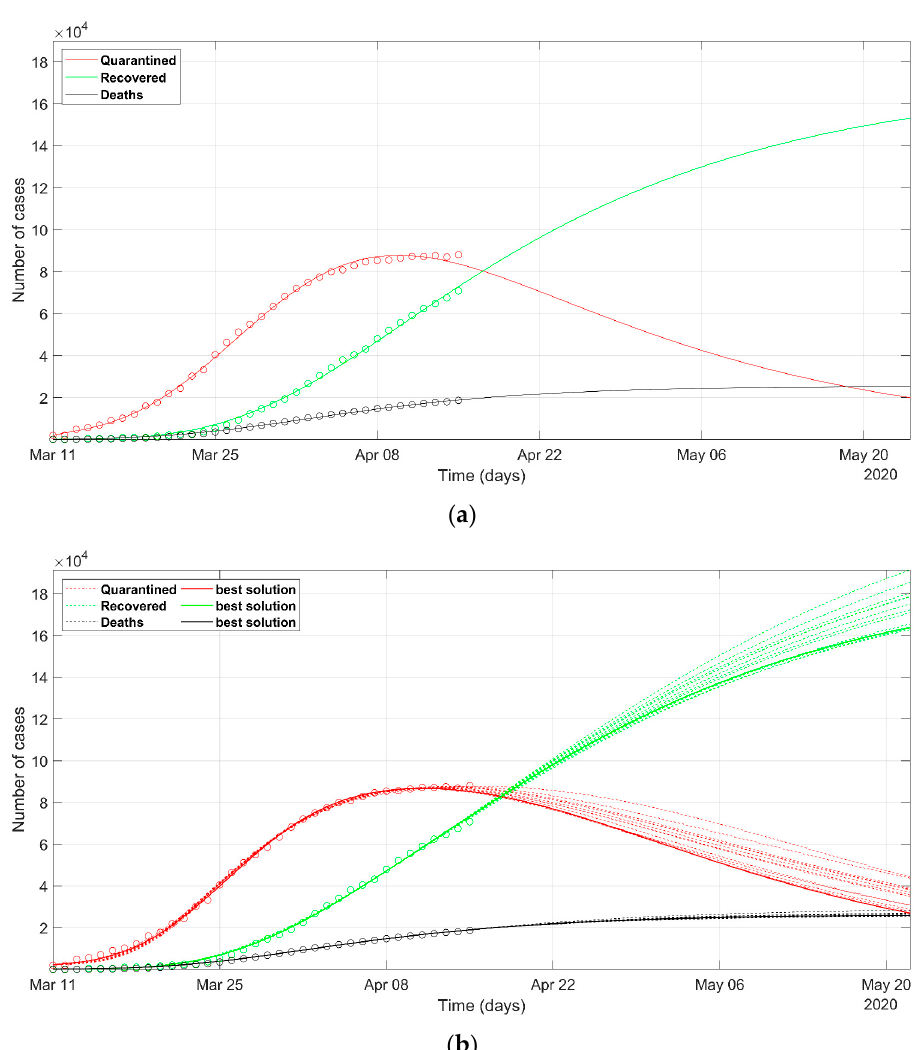
Figure 7. Observed data (circles) of quarantined (red), recovered (green), and deaths (black) for Spain, updated on 15th April 2020. The continuous lines refer to the predicted evolution in 30 days according to the SEIR model solved with ( a ) deterministic approach, ( b ) stochastic approach. In ( b ) the solid line refers to the best PSO solution, the dashed lines refer to the most probable solutions (i.e., the solutions within 5% of the minimum NRMSE).